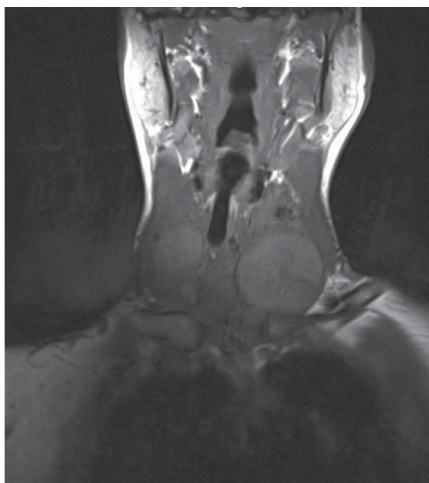
Figure 5: Thyroid, marcocopy image. The tumor measured 4.0 × 4.0 × 3.0 cm, in the left thyroid lobe. It was an expansive tumor with macroscopic infiltration of the capsule, as demonstrated by the